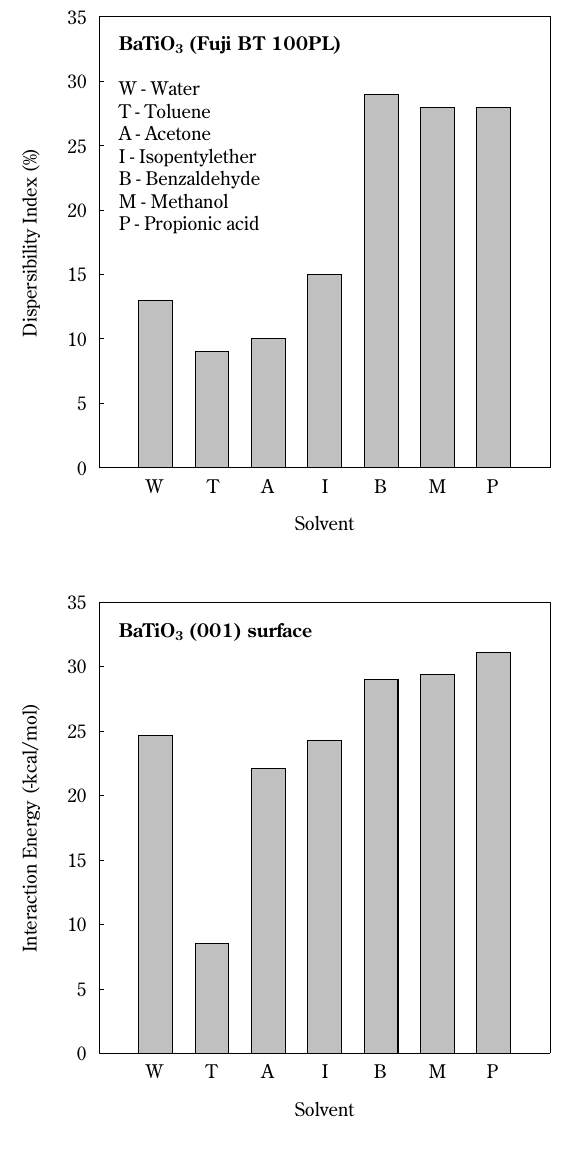
(a) Percent dispersibility index of the Fuji BT 100PL pow- der (data taken from Ref. [44]), (b) Theoretically com- puted interaction energies obtained using MD